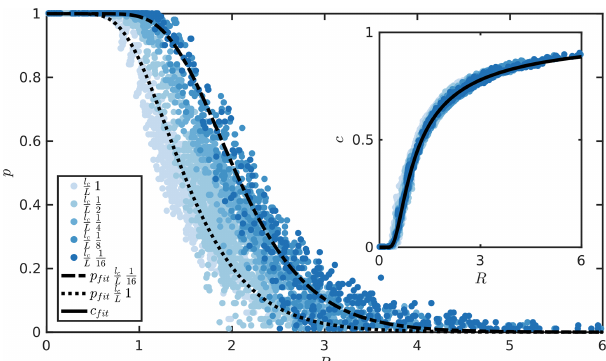
Figure 4. Percolation probability p (Eq. 14) and the mean frac- tional amount of contact c as a function of relative closure R for all fracture realization sets of groups 1 and 2. Different shades of blue indicate different l c /L ratios as given in the legend, whereas black lines show best fits to the